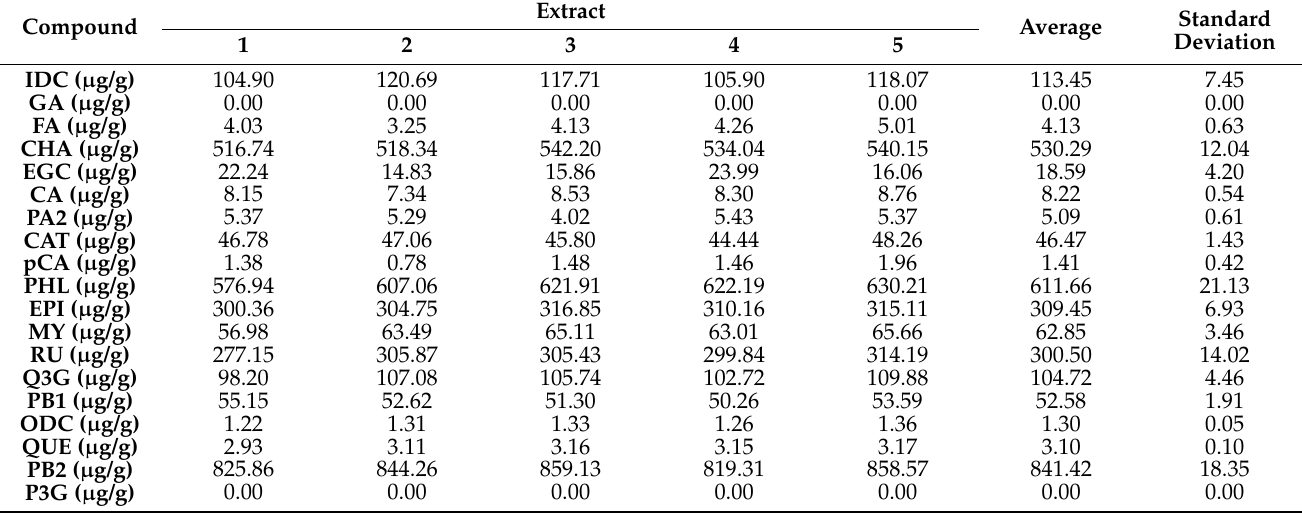
Table A4. Repeatability of solution